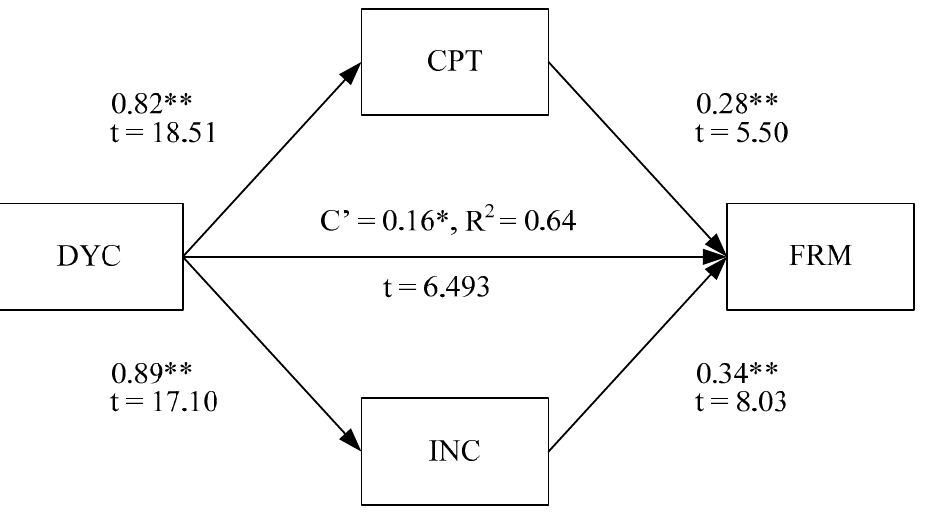
Figure 5. Test of the influence of the full model. Note: * p < 0.05, ** p < 0.001.